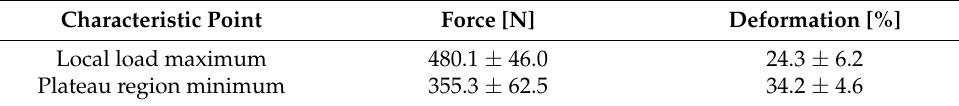
Table 1. Average force and deformation response at the characteristic points of the deformation response of the APM samples with standard deviations in the force and deformation at both charac- teristic